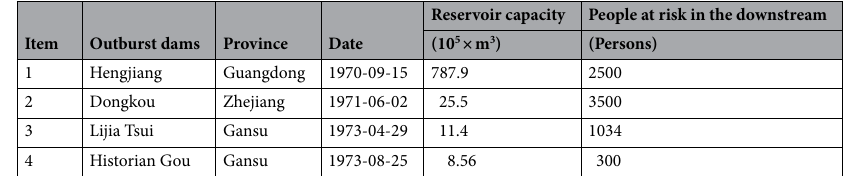
Table 3. Summary of investigation of four outburst dams.